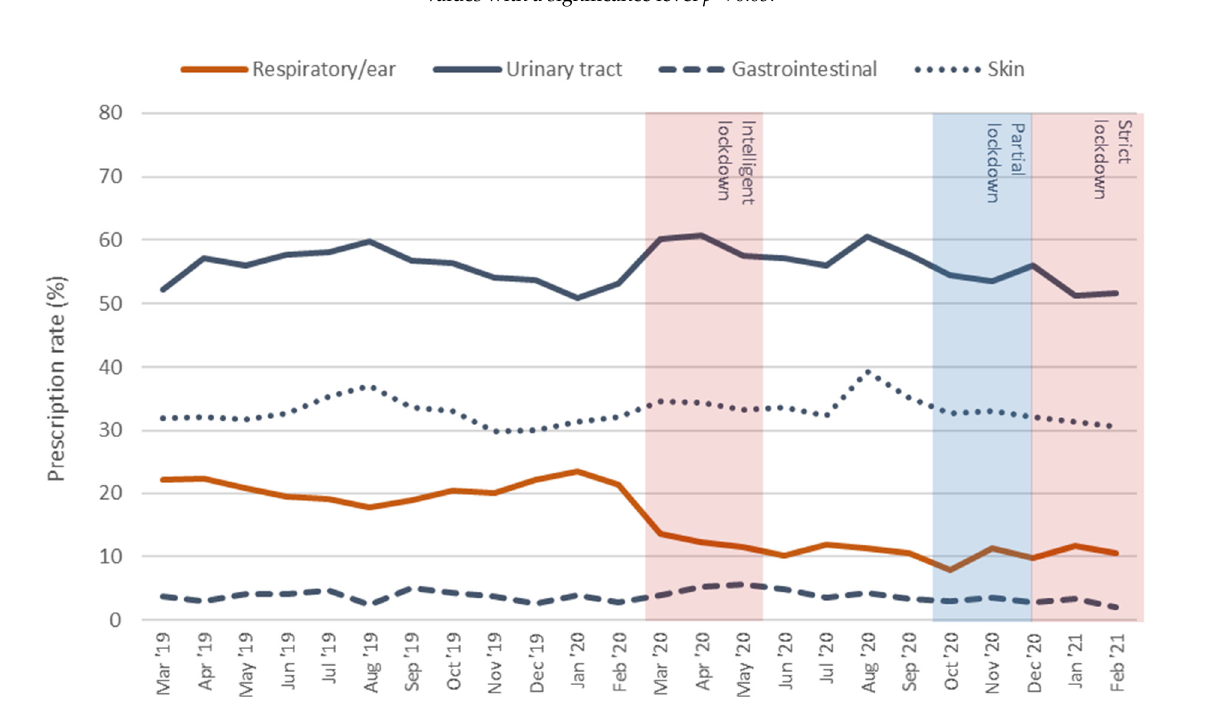
Figure 2. Course of the prescription rate (%) for four common infection types over time per month.